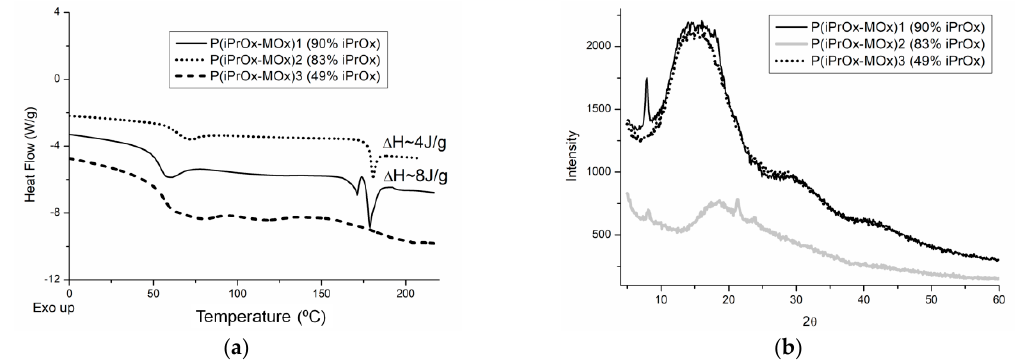
Figure 2. ( a ) DSC traces (heating rate of 10 °C/min) and ( b ) X-ray diffraction curves for iPrOx/MOx copolymers annealed at 150 °C for 1 h.